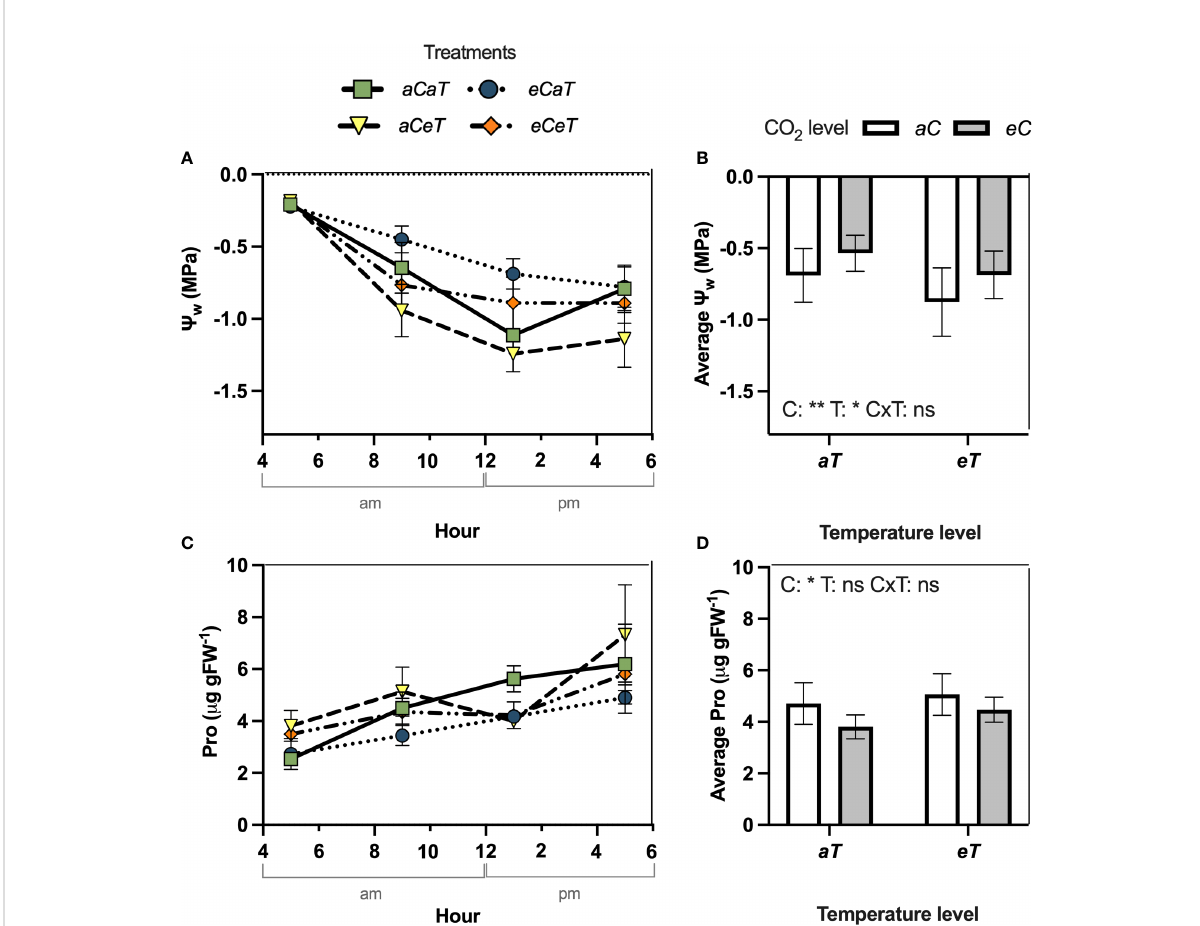
FIGURE 4 Diurnal course of water potential and leaf proline content measured in fully expanded leaves of M. maximus in different levels of [CO 2 ] and temperature during the diurnal period (left column) and diurnal average values (right column). Y w = water potential. Pro = leaf proline content. Treatments: aC (ambient CO 2 concentration), eC (elevated CO 2 concentration – 600 ppm), aT (ambient temperature), and eT (elevated temperature - 2°C above ambient temperature). ANOVA results are shown for diurnal averages: C: [CO 2 ] effect, T: temperature effect, C×T: interaction between C and T. *P < 0.05, **P < 0.01, ***P < 0.001, ns, non-signi fi